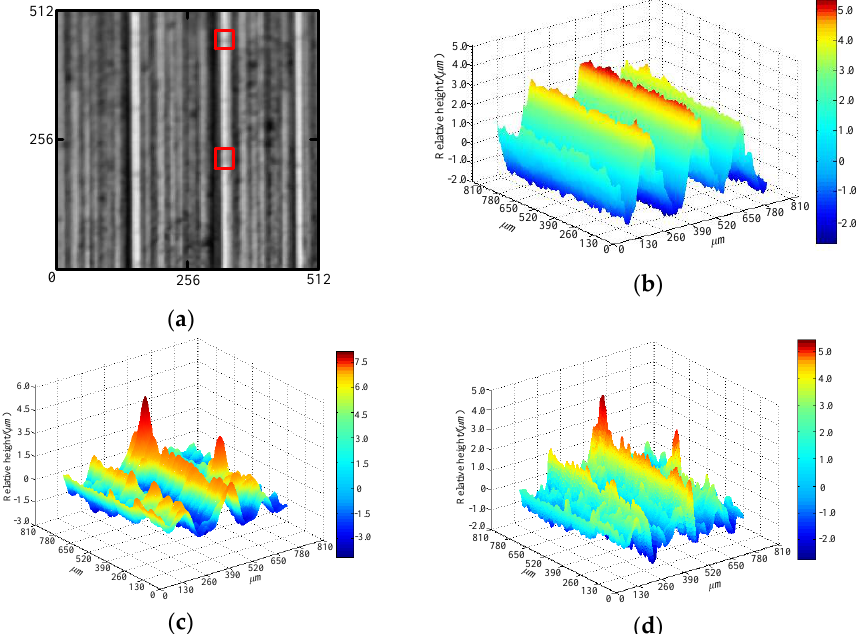
Figure 12. Experimental results for milling surface image: ( a ) Milling surface image; ( b ) Measured result; ( c ) Reconstruction result of Horn and Brooks algorithm; and ( d ) Reconstruction result of proposed algorithm.